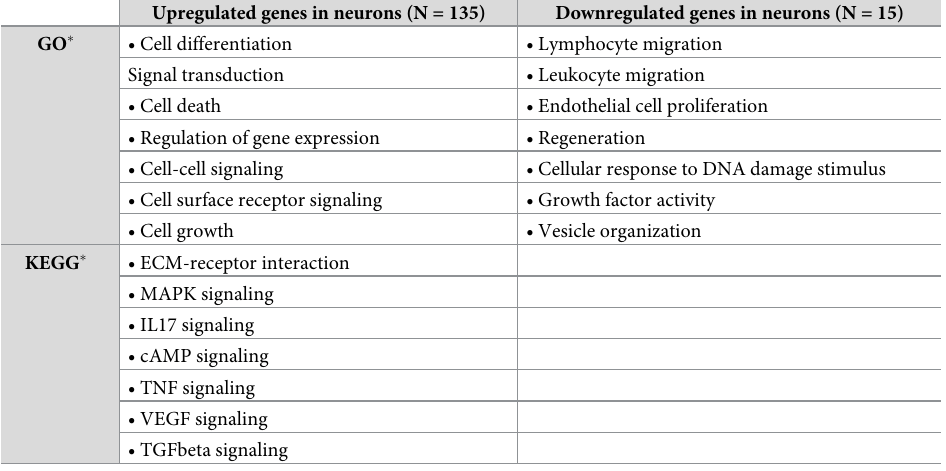
Table 3. Relevant GO and KEGG terms of up- and downregulated genes in neurons at 24 hours post injection in the intracortical kainic acid model of mTLE.